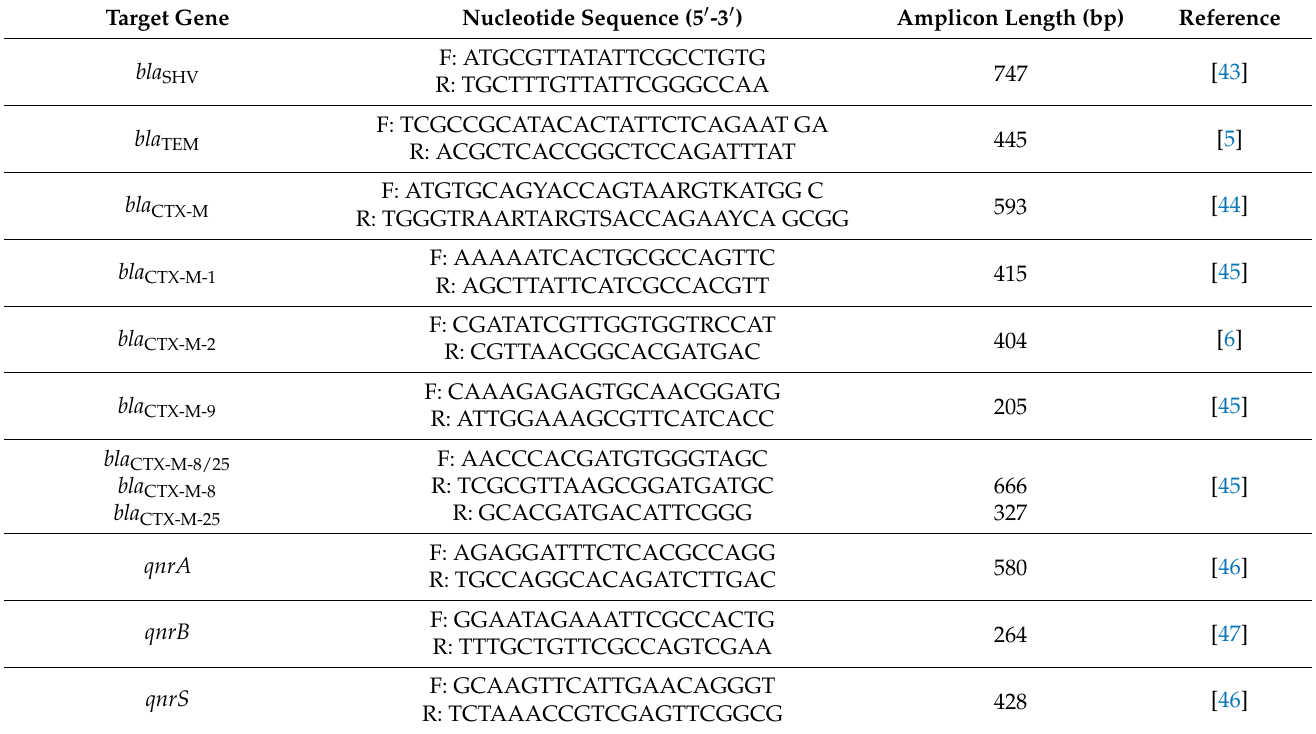
Table 5. Resistance gene targets and primers used in the present